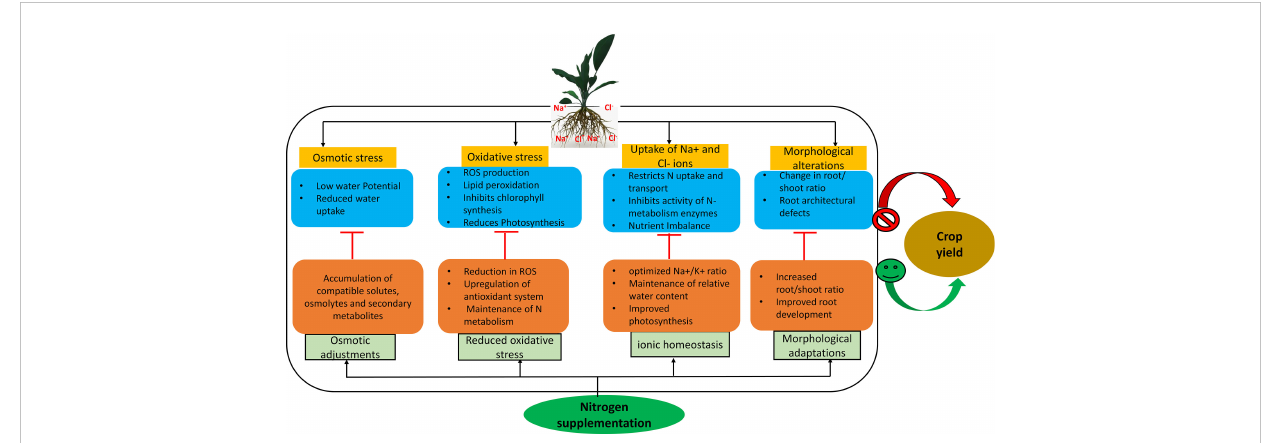
FIGURE 1 N supplementation exerts a defensive response on plant physiological and morphological machinery during salt stress and helps in alleviating the osmotic stress, oxidative damage and morphological alterations. N also help in maintaining the ionic homeostasis along with N metabolism in plants during salt stress, which in turn helps in improving the plant performance during salt stress. Cl - , chloride; N, Nitrogen; Na + , sodium; K + , Potassium; ROS, reactive oxygen